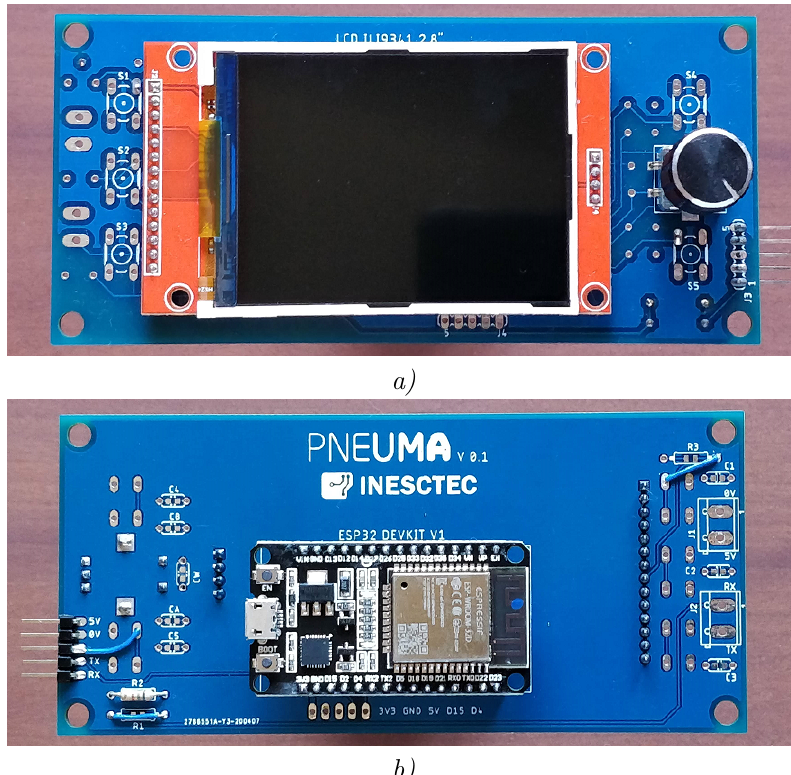
Fig. 7. LCD interface and ESP32 controller with Wi-Fi, front (a) and back